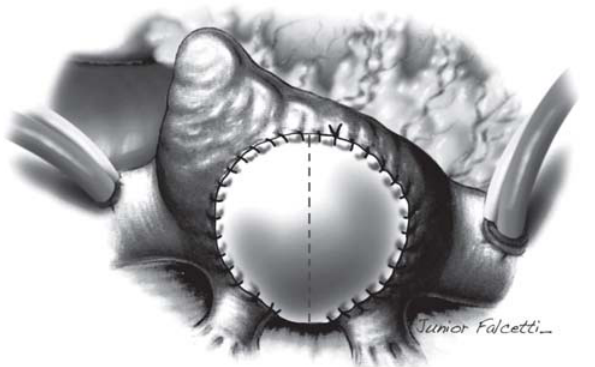
Fig. 2 - Retalho de politetrafluoroetileno empregado para ampliação do túnel das veias pulmonares